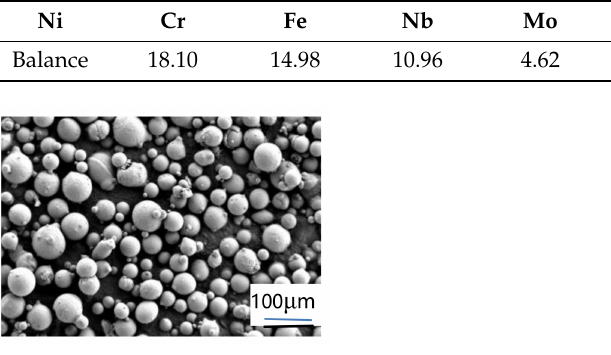
Figure 1. SEM image of Inconel 718 raw material powder.